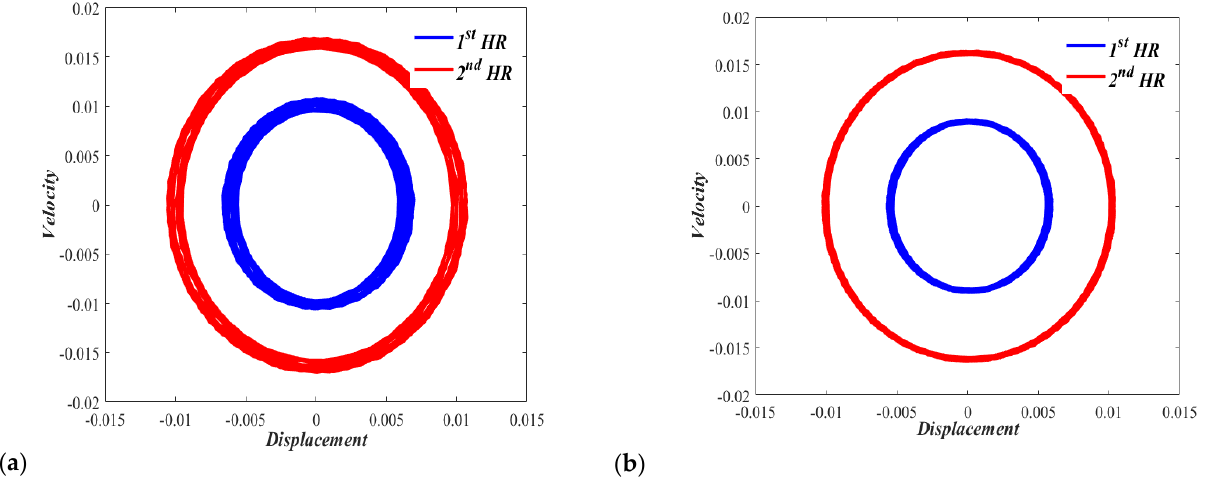
Figure 8. Phase portrait for the nonlinear dual HR excited by p = 150 dB, ( a ) Ω = 0.65, and ( b ) Ω = 1.65.